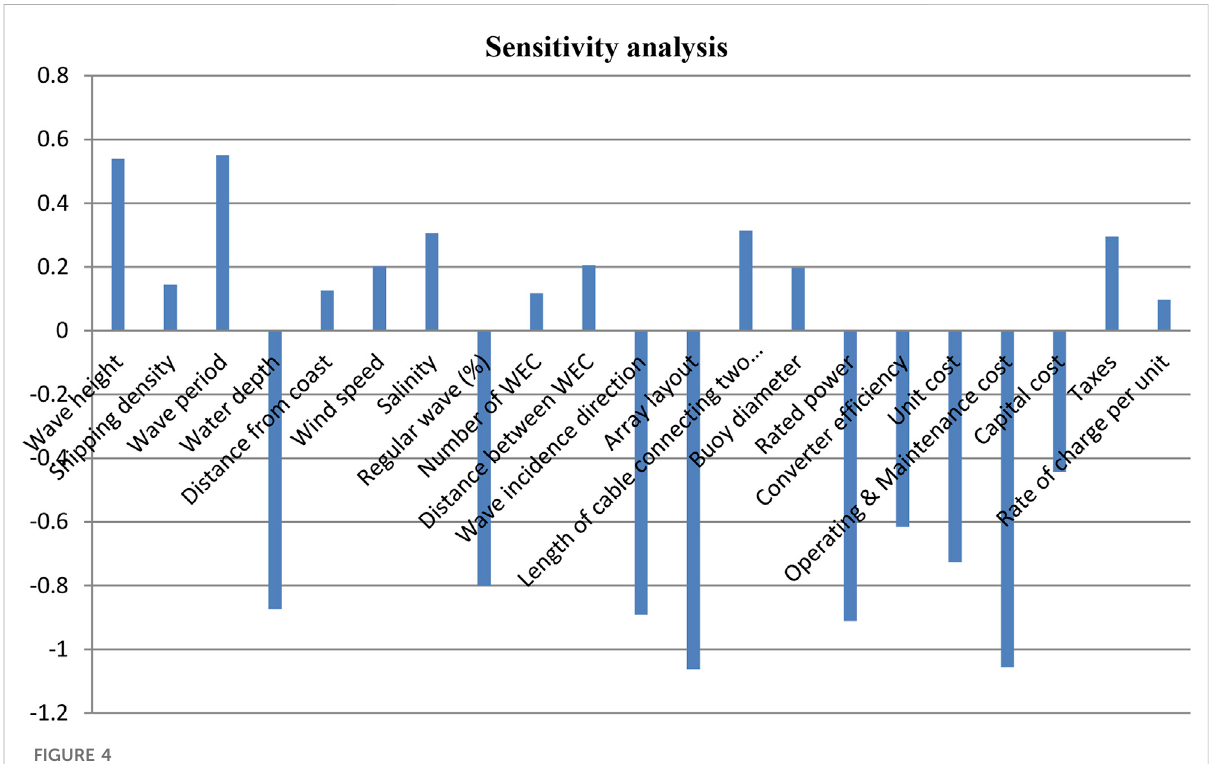
FIGURE 4 Figure depicting the input variable ’ s sensitivity